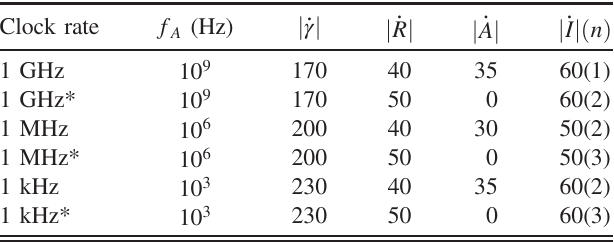
TABLE I. Practical combinations of system components